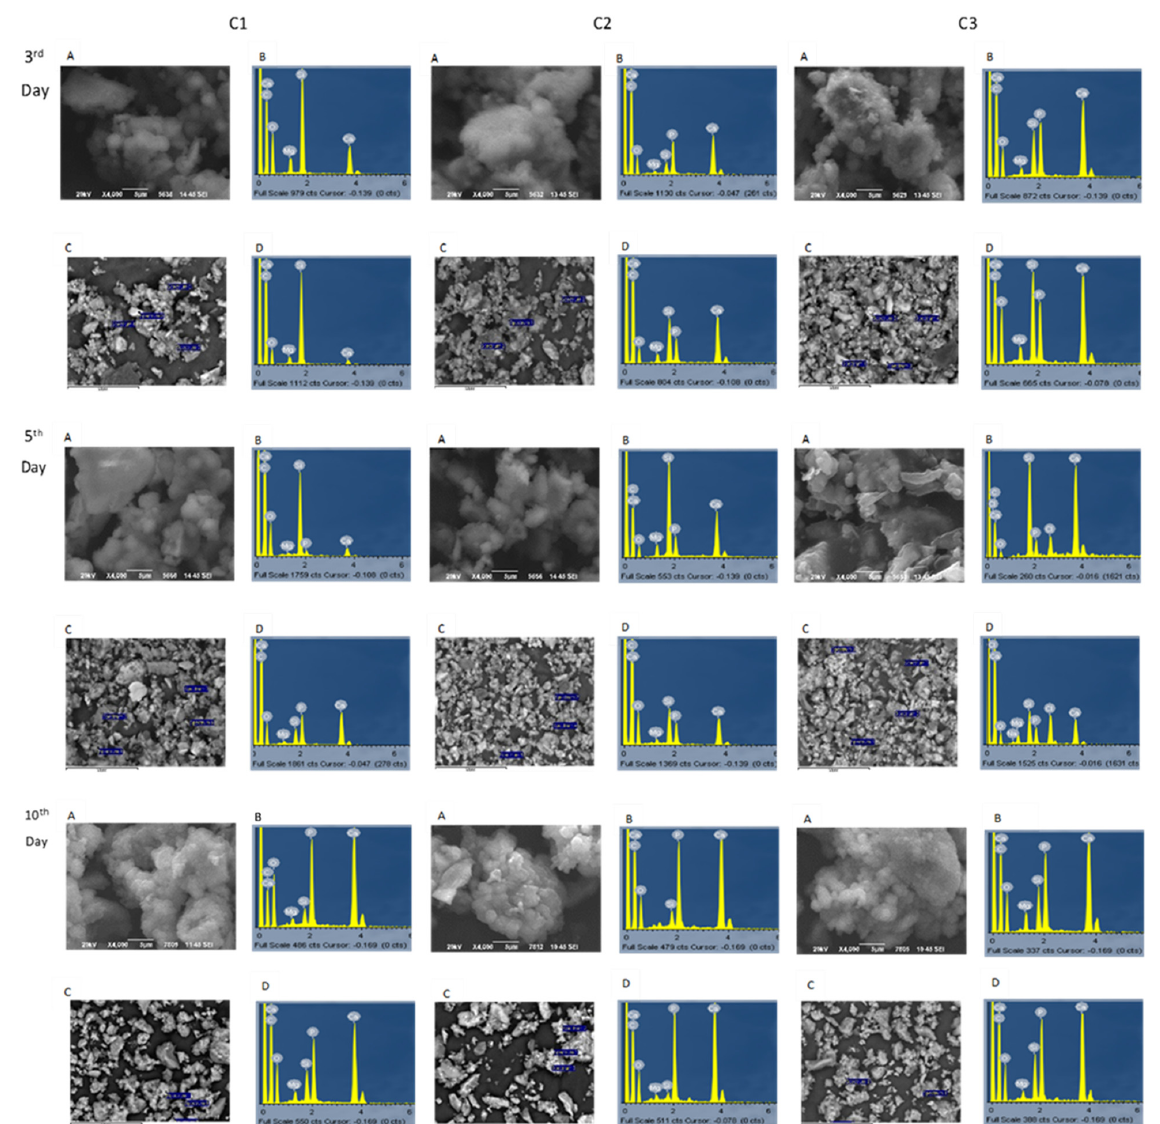
Figure 7. ( A ) SEM microphotographs of the C1, C2, and C3 samples after the immersion in SBF (3, 5, 10 days), ( B – D ) EDS spectra from two different regions (spectrum 1, 2) of each sample .